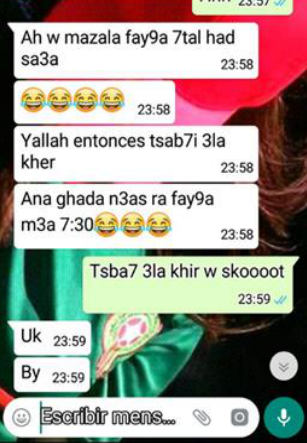
Figure 5 . Example 8.